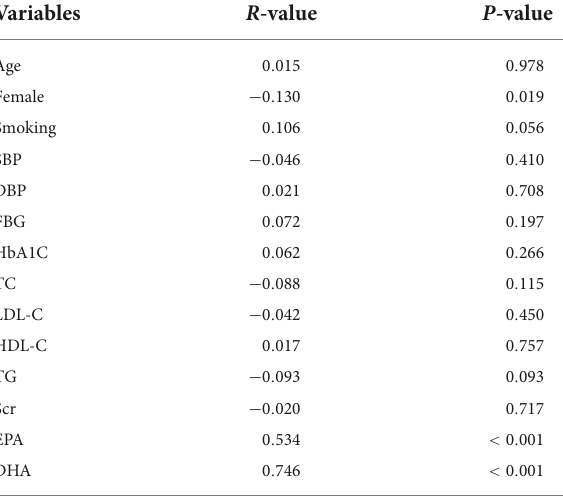
TABLE 2 Correlation of arachidonic acid and other baseline variables. TABLE 3 Association of serum EPA, DHA, AA and their ratios with CAD in young patients by multivariate logistic regression analysis.